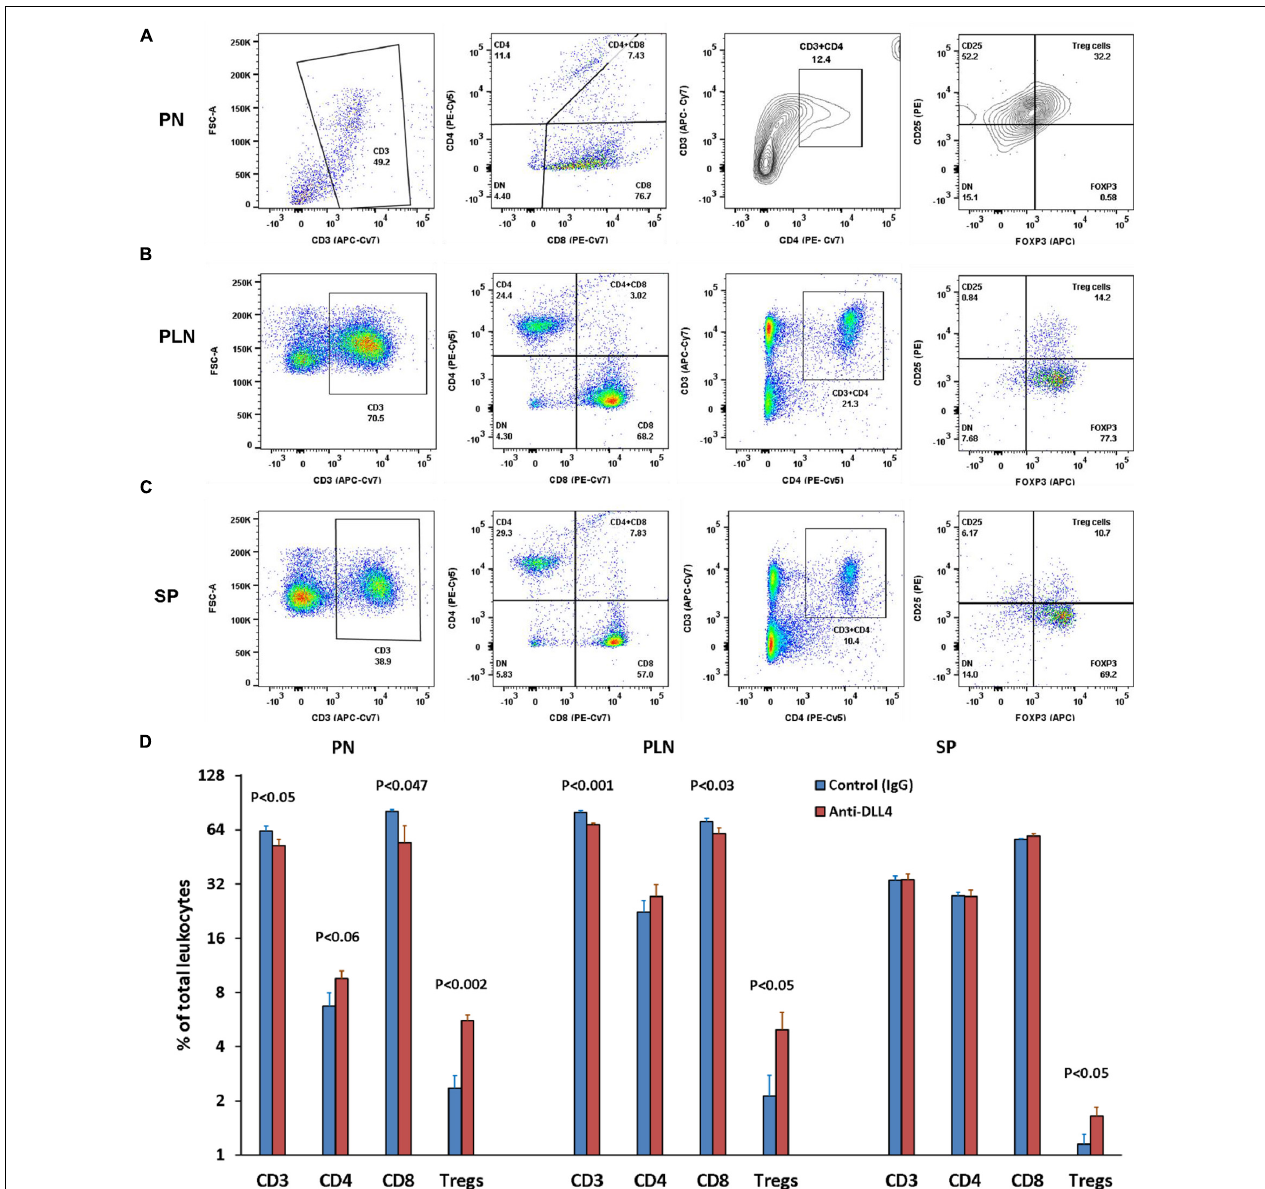
FIGURE 2 | Anti-DLL4 significantly reduces CD8 T cells and enriches the Treg population. Representative flow-cytometry (dot plots) of three anatomical sites. (A) Pancreas (PN) (B) pancreatic lymph nodes (PLN) and (C) spleen (SP) of mice. Single cell suspensions were stained with fluorochrome-conjugated antibodies. First CD3 T cells were gated from the peripheral blood mononuclear cells (PBMCs) and subsequently gated for CD4, CD8 and (CD4 + CD25 + FOXP3) Treg cells from all anatomical sites ( n = 4 per group). Data shown in histograms for CD3, CD4, CD8 and Treg cells were found in anti-DLL4 and Control IgG treated mice (D) . Most remarkably, at PN and PLN, CD3 and CD8 T cells were significantly reduced in anti-DLL4 treated group while Treg enrichment was recorded in PN, PLN, and SP of anti-DLL4 treated